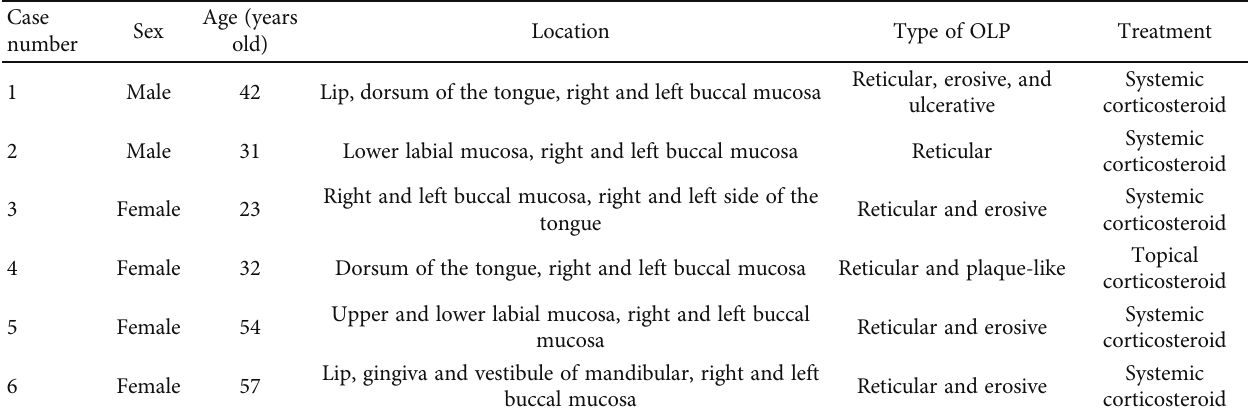
Figure 6: The clinical features of OLP in a 57-year-old woman; (a) erosive lesion and Wickham striae on the right lower lip; (b) – (d) bilateral erosive lesion surrounded by Wickham striae on the right and left buccal mucosa; (e) – (h) lesions showed improvement after 2 months of treatment; (i) and (j) microscopic appearance of the lesion with 100x and 400x magni fi cation. Table 2: The characteristic of the patients, clinical pro fi le of OLP, and the